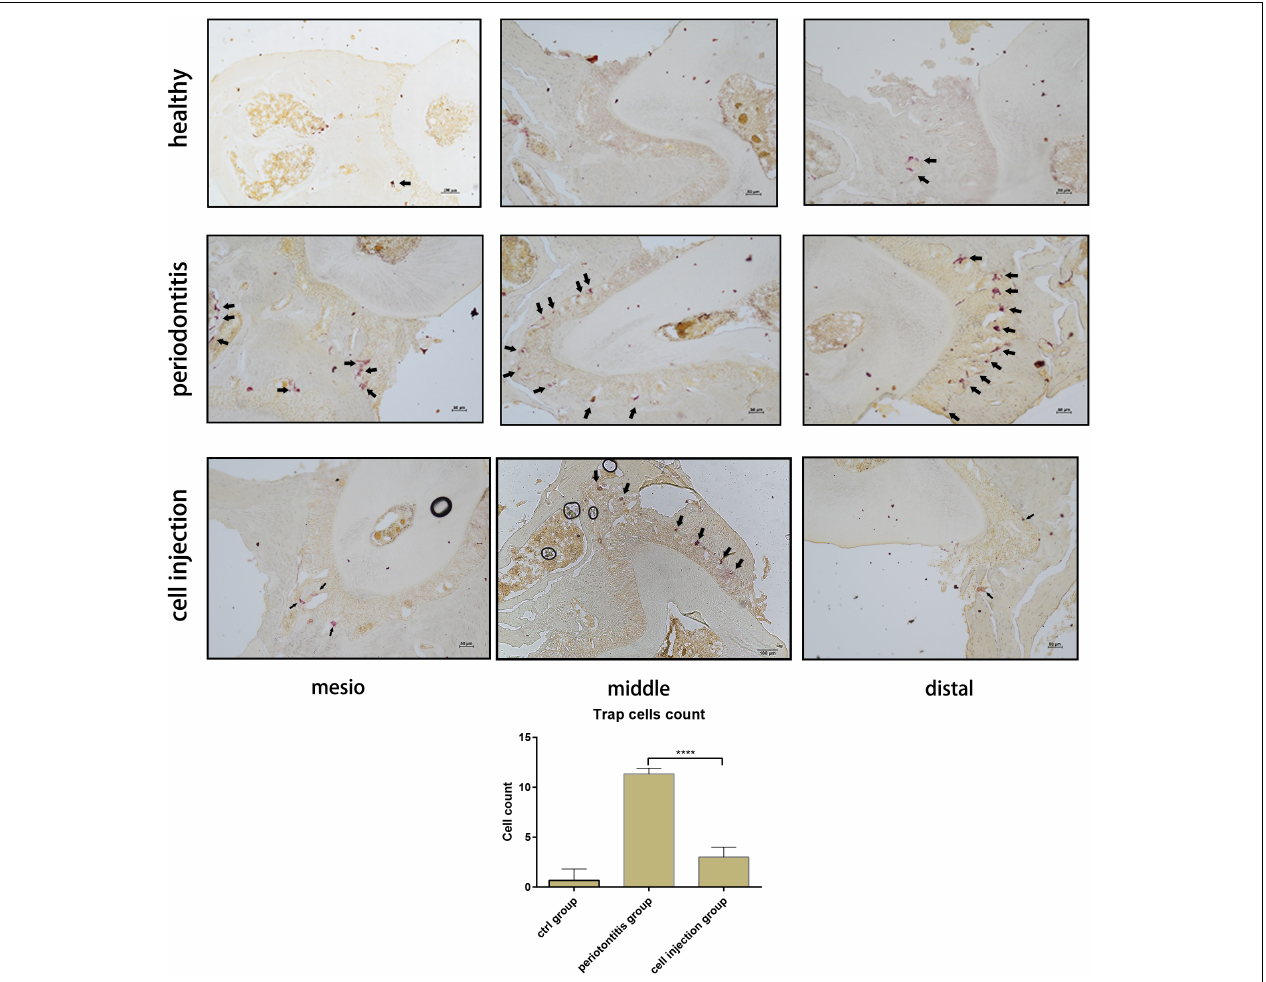
FIGURE 4 | Tartrate-resistant acid phosphatase (TRAP) staining of osteoclast in the periodontal ligament of the distal, middle, and mesial sites of the second molar. The cell counts of TRAP-positive cells are shown as means ± SD; the statistical significance was determined by P -value (*** P <